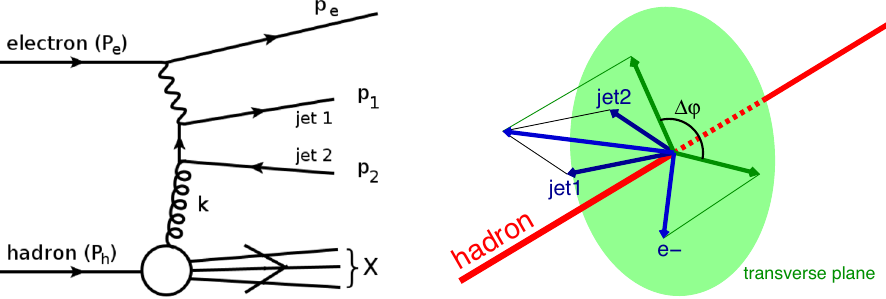
transverse plane